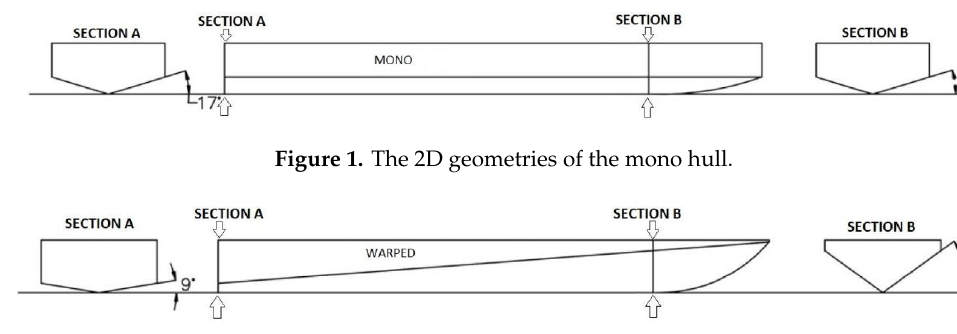
Figure 2. The 2D geometries of the warped hull.